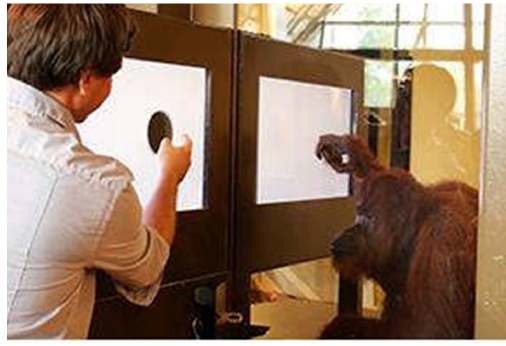
Figure 9. Human and orangutan playing together with a touchscreen interface [97].